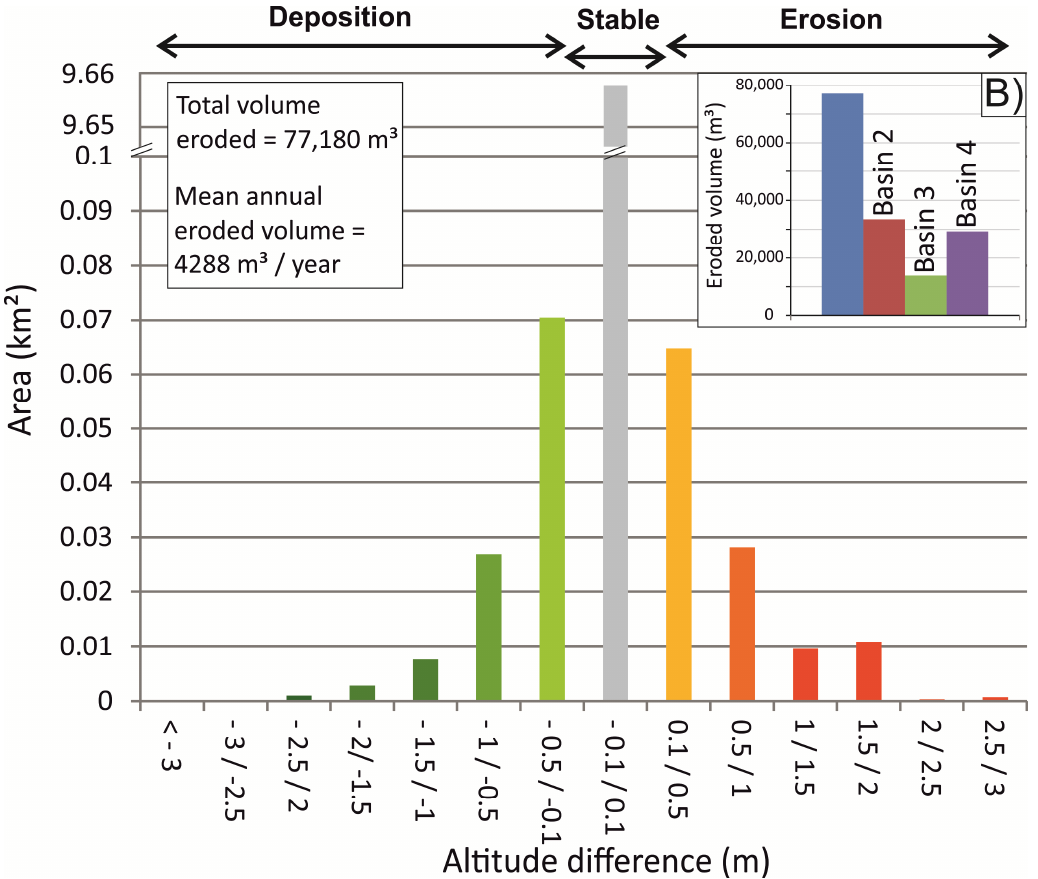
Figure 8. Histogram showing the distribution of the erosion/deposition classes deriving from the geographical information system (GIS)-supported analysis of the altitude difference